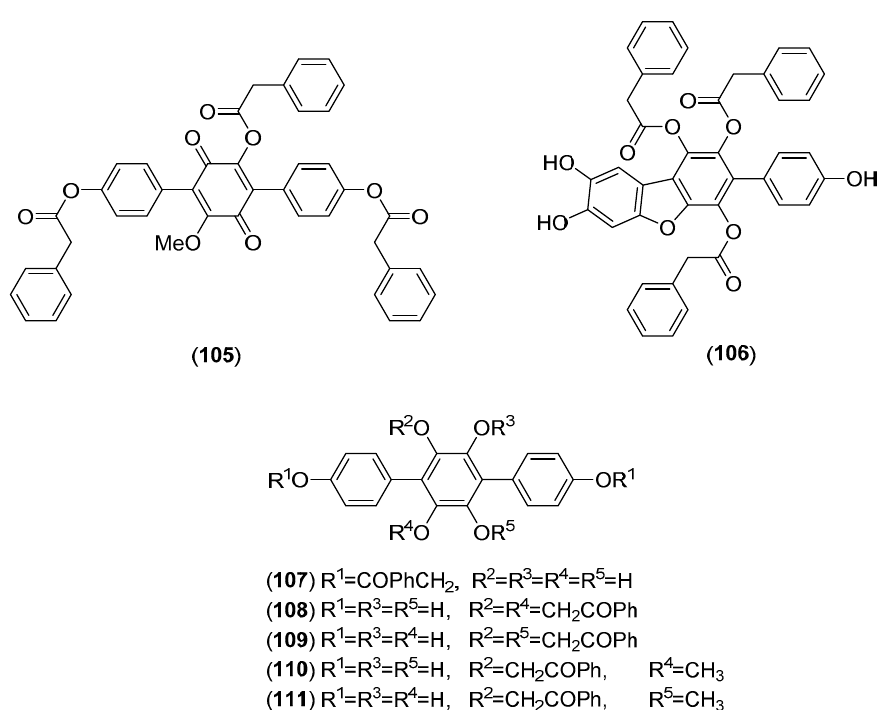
Figure 19. Chemical structures of selected compounds isolated from Thelephora ganbajun .